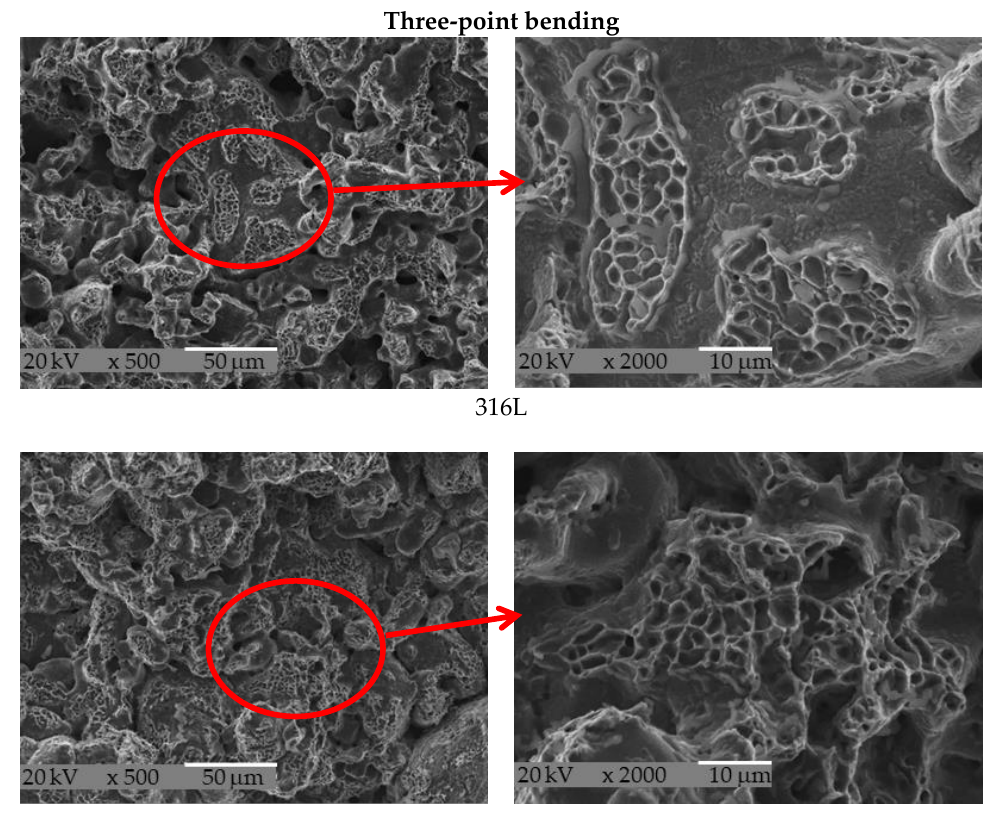
Figure 13. Topography of fractures of sintered AISI 316L austenitic stainless steel powder with the addition of 0.3 wt% of nanographite powder with 400 m 2 /g BET after impact test, static tensile test, and three-point bending test.